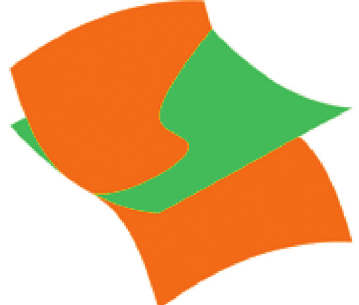
Figure 4: Intersection of both surfaces.